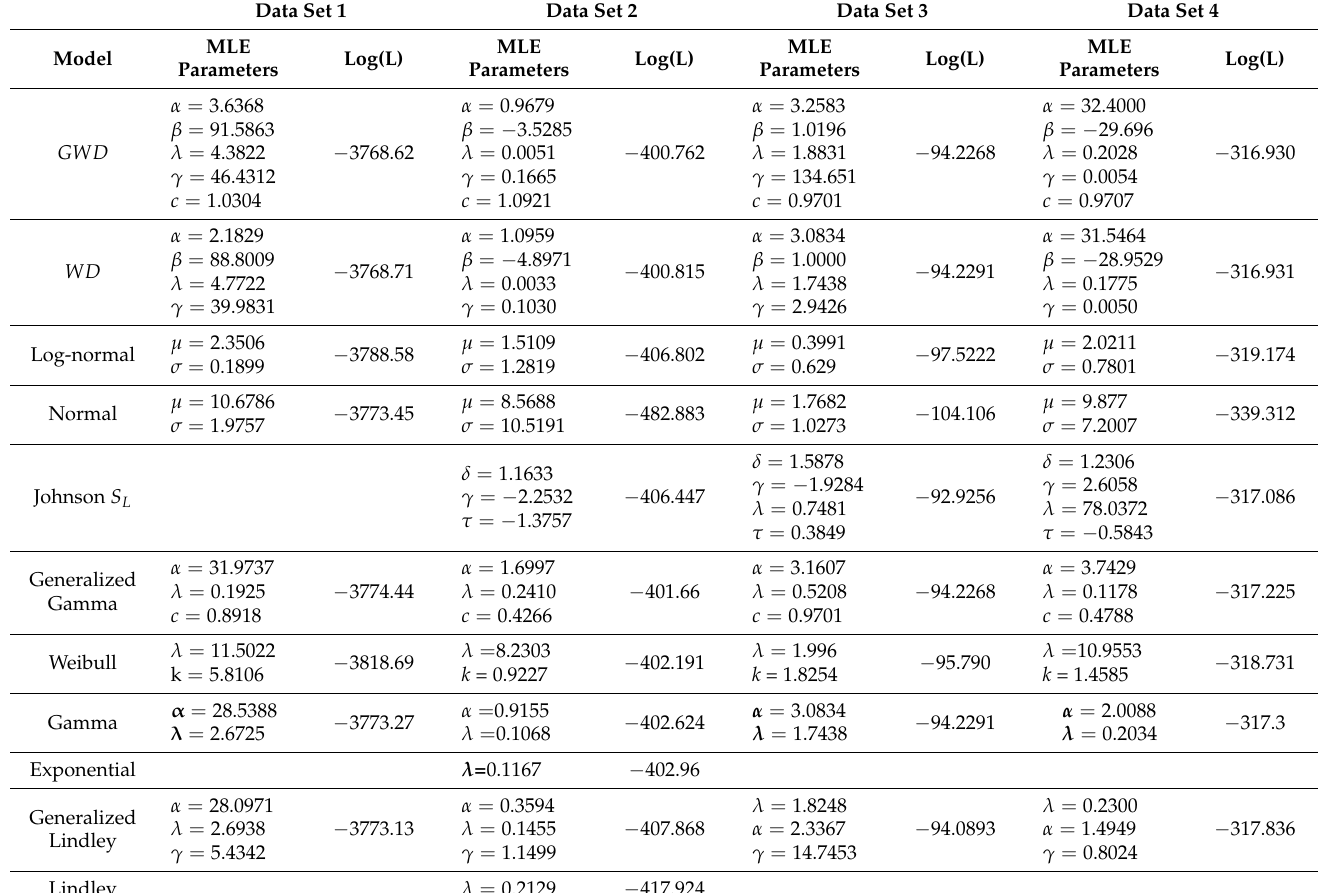
Table 1. Estimation results for all data sets.